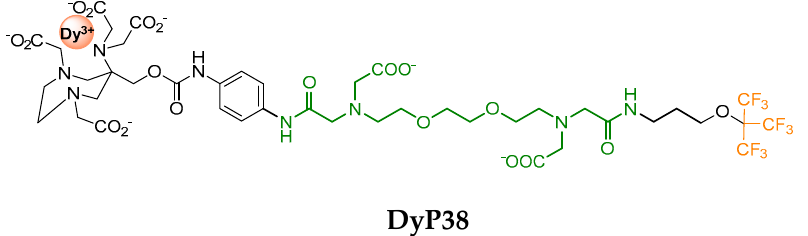
Figure 14. Paramagnetic probe sensitive to Ca 2+ and used as a cocktail with the corresponding YP38 for Ca 2+ quantification.